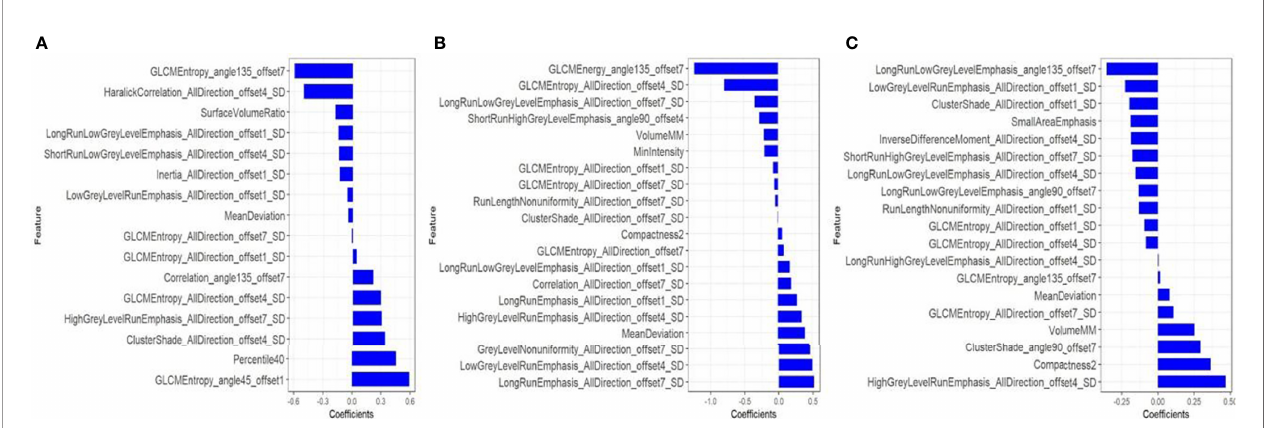
FIGURE 2 | After dimensionality reduction by mRMR and LASSO, 16, 20 and 19 radiomics features were fi nally selected from CT-enhanced images (A) , T2WI (B) and CE-T1WI (C) to construct a radiomics signature. The blue bar indicates the weight value of the